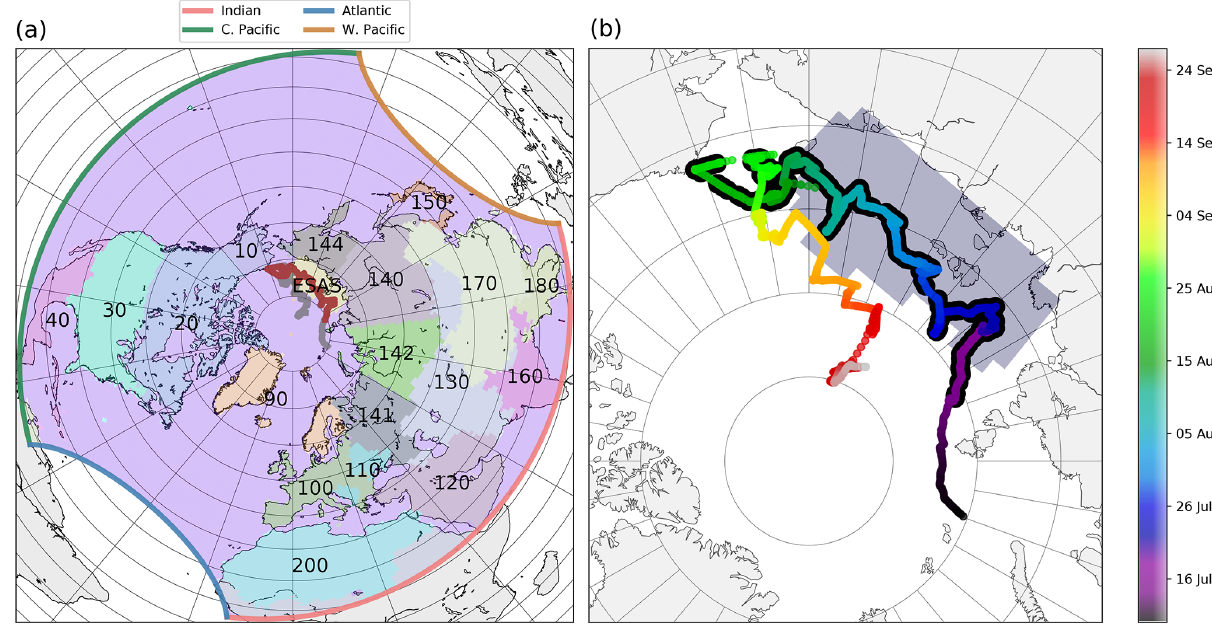
Figure 1. Path of the icebreaker Oden during the SWERUS-C3 campaign and domain of simulations. (a) The ship positions are represented by grey and brown lines, with brown parts corresponding to locations where isotopic observations where carried out. The area delimited by coloured lines is the domain of CHIMERE simulations used for this study (see Sect. 2.2). The shaded areas and associated numbers correspond to the regions and their IDs used to separate contributions from remote emissions to the observed signal, as detailed in Sect. 2.3. ESAS is the East Siberian Arctic Shelf. CHIMERE boundary conditions are split along the four sides of the domain as indicated by the coloured lines. (b) Zoomed-in view of the area covered by the campaign. The icebreaker’s locations are coloured based on their corresponding dates. Ship positions with a black edge are locations where isotopic observations where carried out. More details on the campaign in Thornton et al. (2016a). The shaded area corresponds to the ESAS emission region used in our simulation